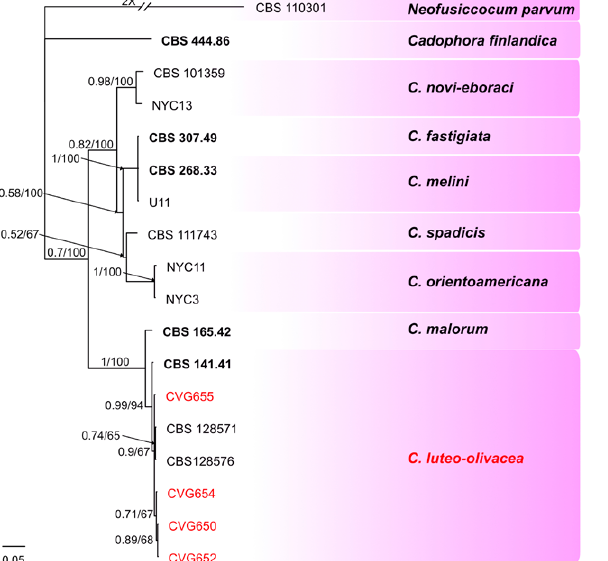
Figure 6. Consensus phylogram of 782 trees resulting from a Bayes- ian analysis of the combined ITS and tub2 sequences of Peroneu- typa and other strains of the Diatrypaceae. Bayesian posterior probability values and bootstrap support values are indicated at the nodes. The tree was rooted to Liberomyces pistaciae (CBS